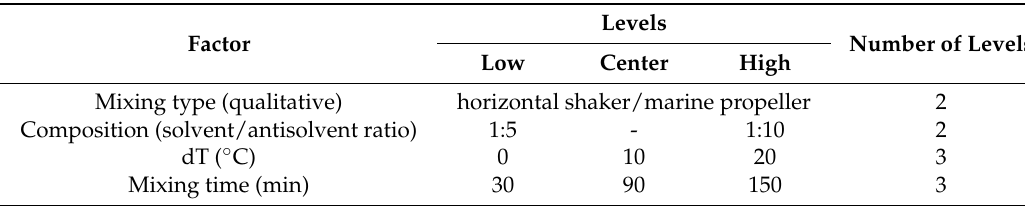
Table 4. The levels of the applied factors during the factorial design.